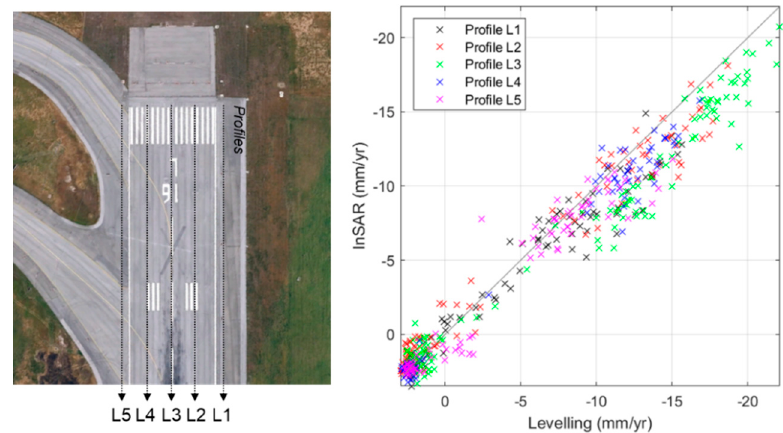
Figure 5. Displacement velocity scatter plot comparing observed (levelling) and predicted (PSI) data.